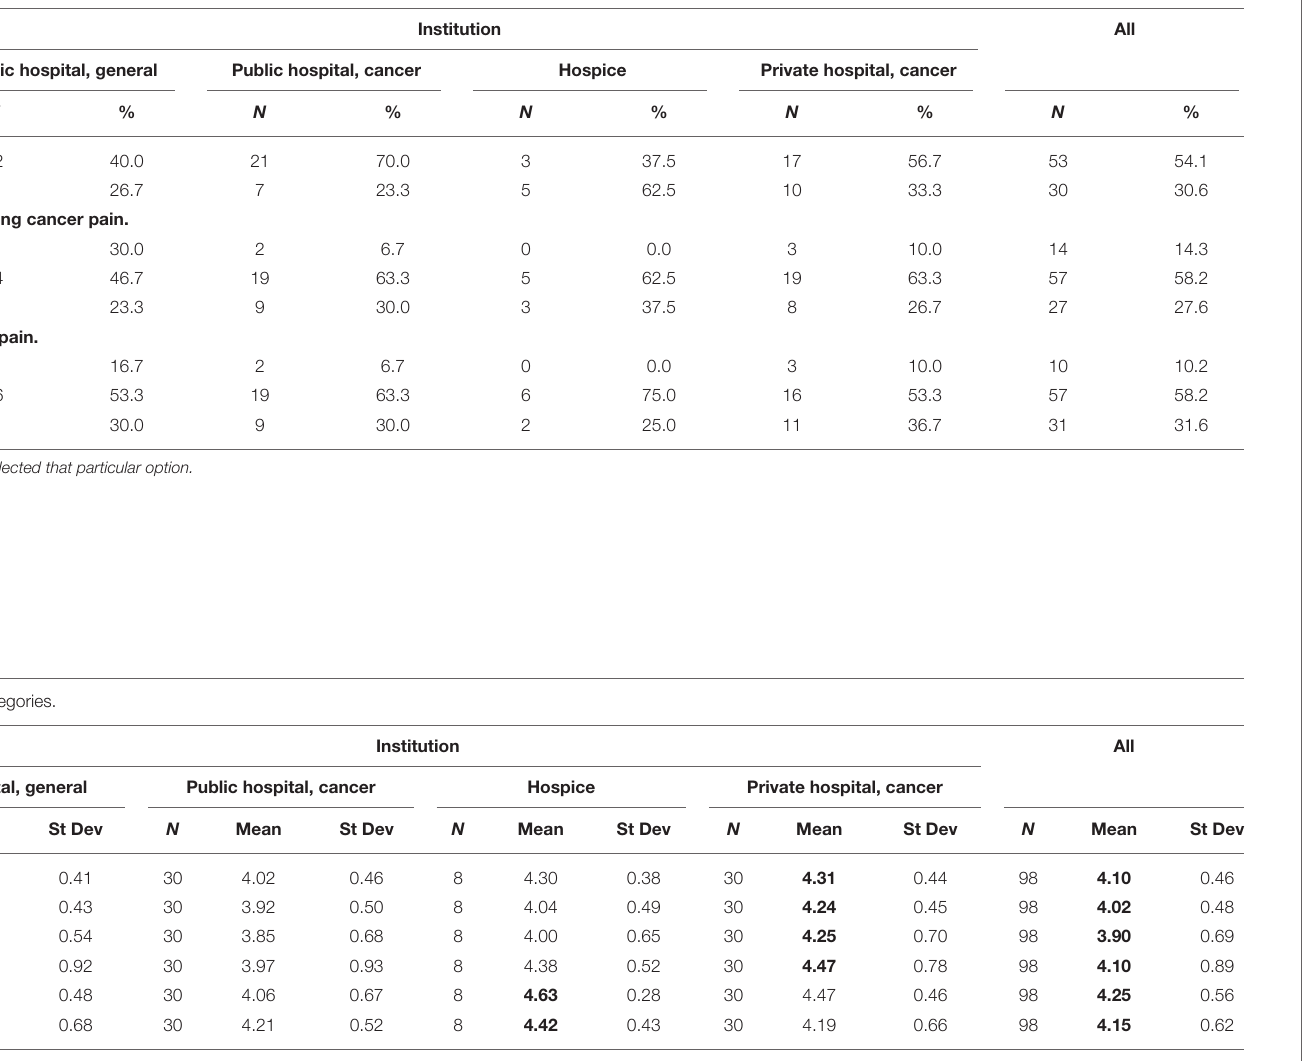
The bold values indicate the highest